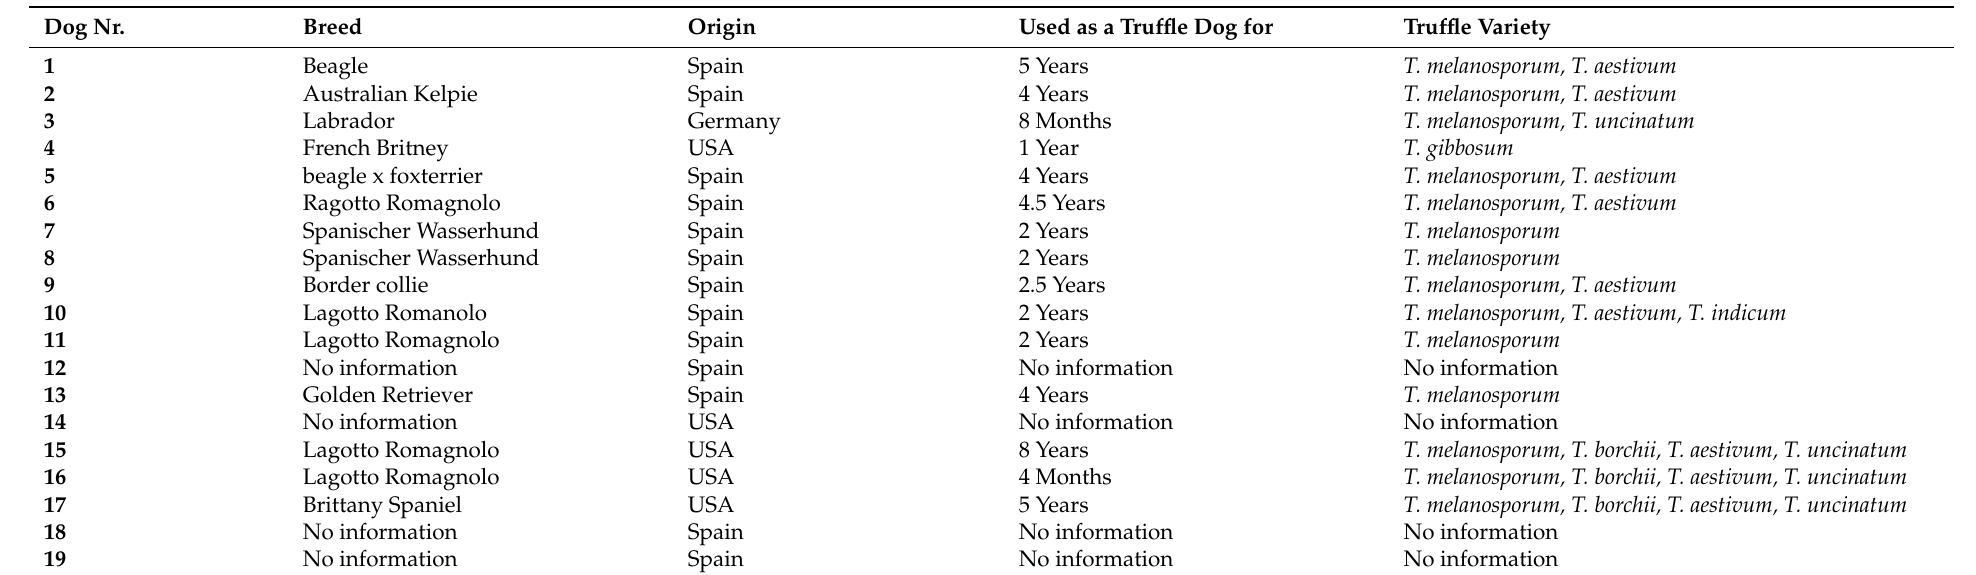
Table A3. Additional information on the truffle